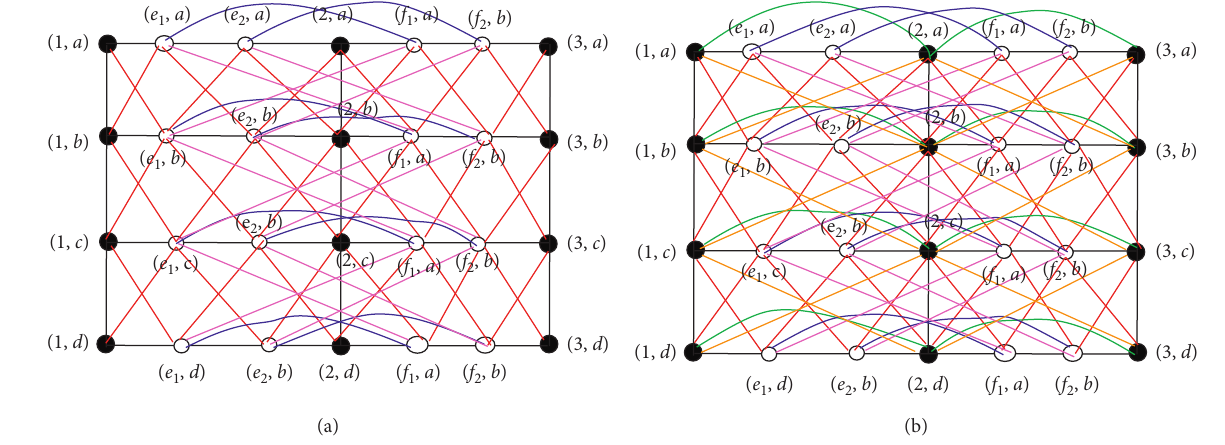
P . Left: � P 3 ⊠ Q 2 4